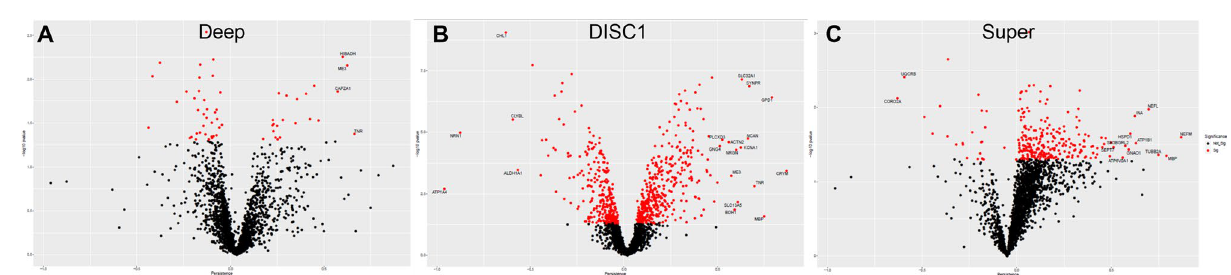
Figure 3. Persistent, significant genes in SCZ. Volcano plots of persistence scores and − log10 p values from ( A ) Deep, ( B ) DISC1, and (C) Super datasets. Red dots signify significant ( p < 0.05) genes, and labels signify genes that also surpassed the persistence cutoff of 0.5. These genes were assigned as having low (< − 0.5) or high (> 0.5) persistence and used in subsequent analyses. See Table 1 for a full list of persistent genes. Figures produced using ggplot2 48